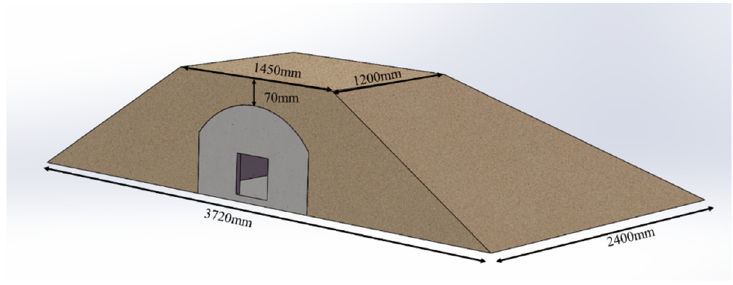
Figure 2. Model of covering soil.